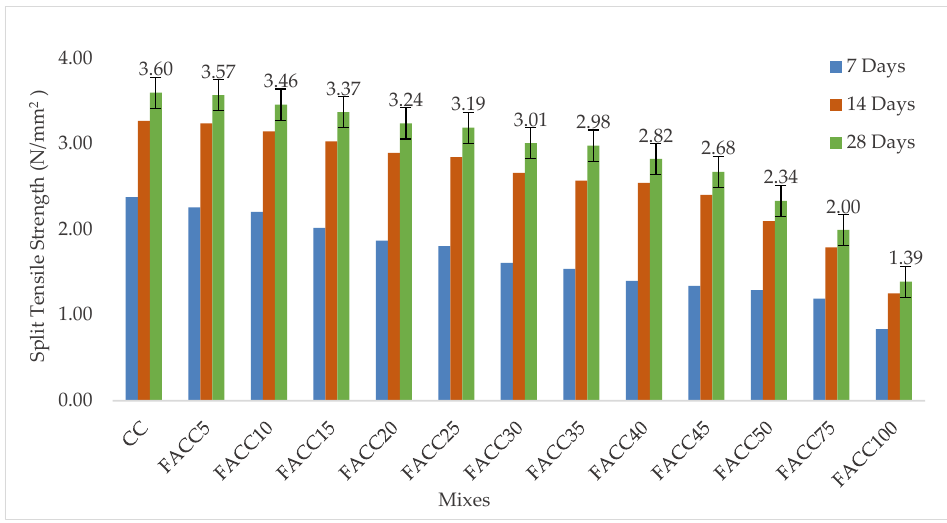
Figure 6. Variation of Split Tensile Strength with Age for CC and FACC Mixes.